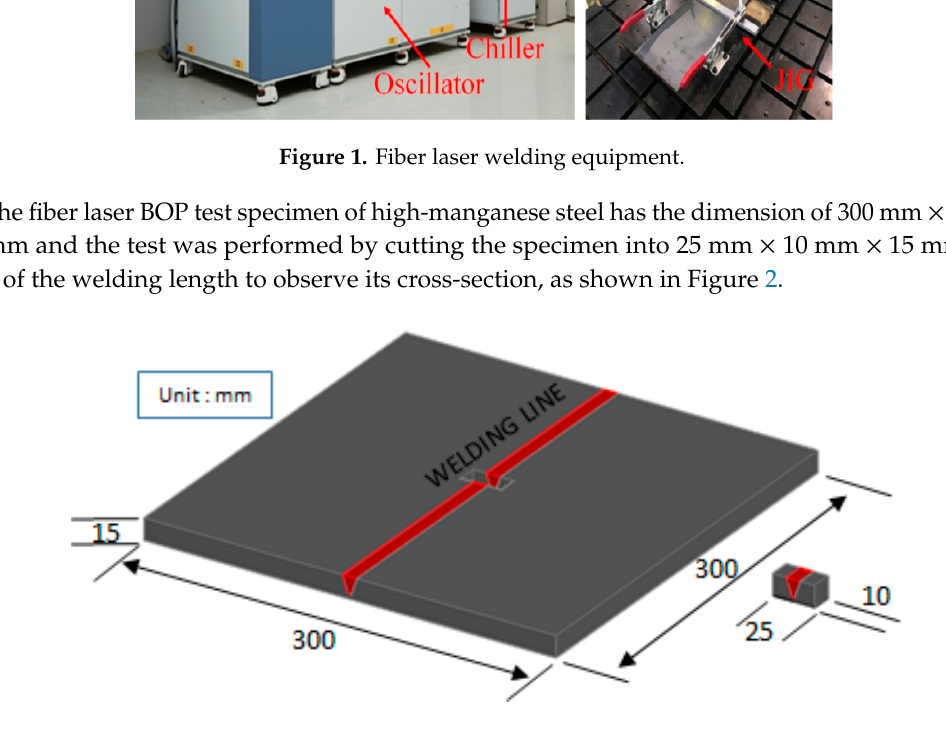
Figure 2. Welding specimen and coupon for cross-section observation.